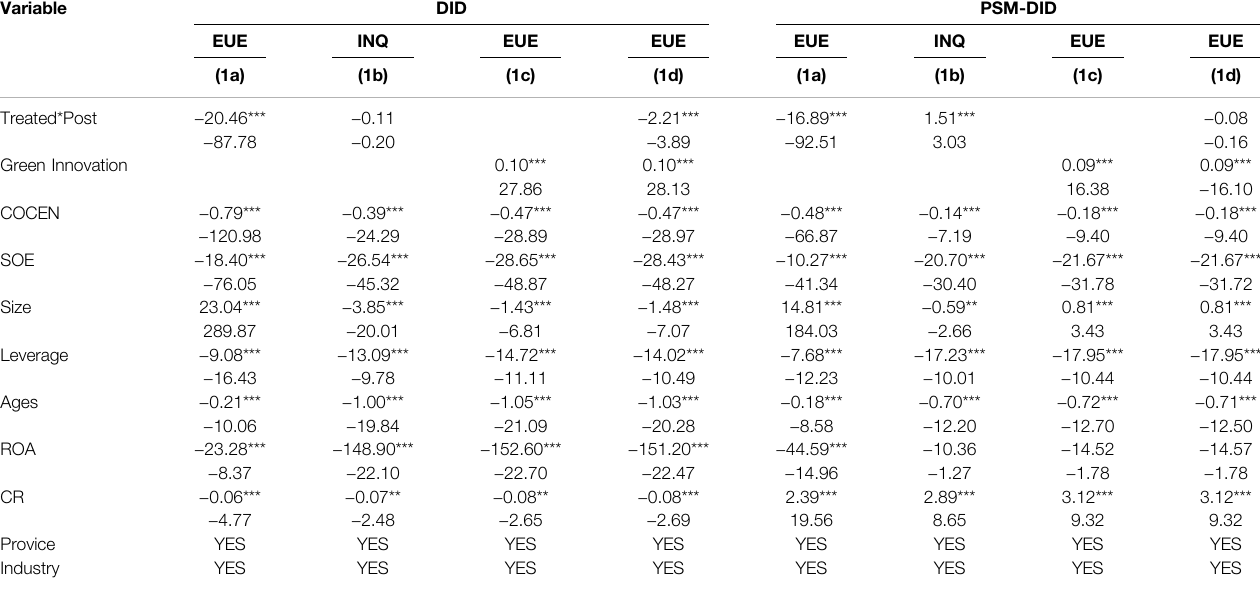
TABLE 11 | OLS robust standard error regression results about excitation.